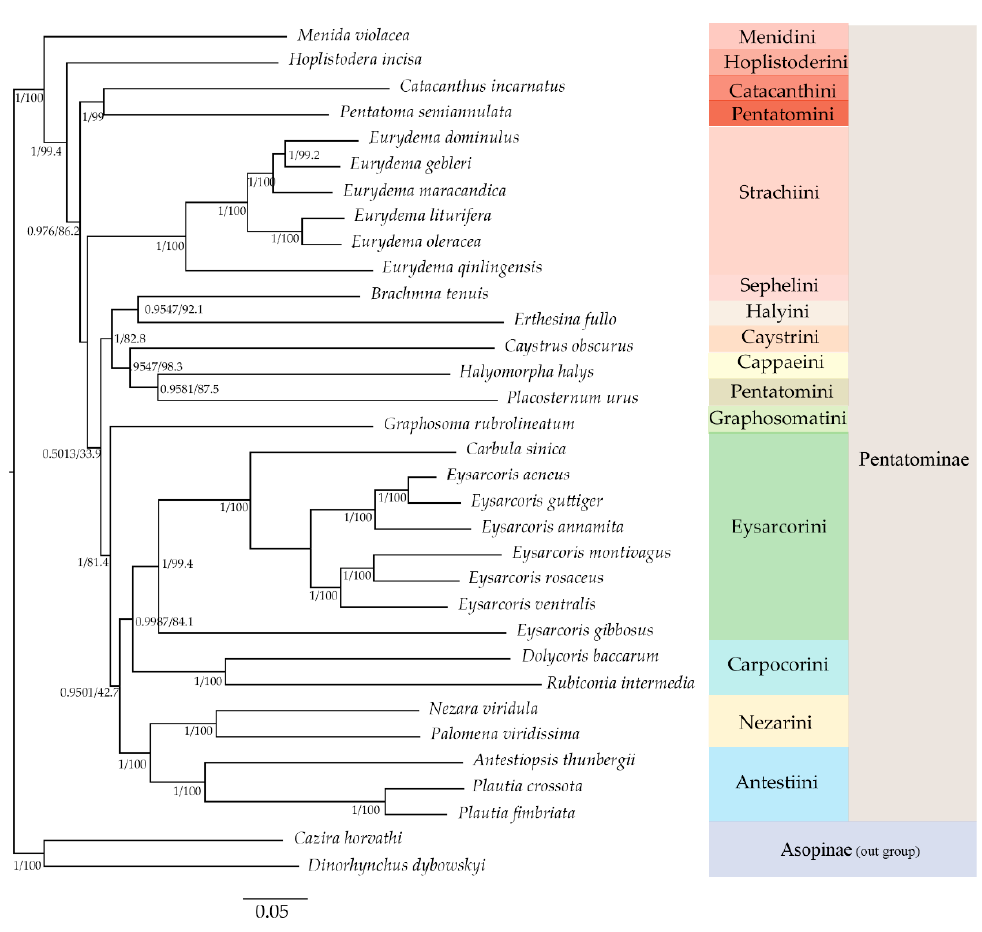
Figure 8. The phylogenetic relationships of tribes within Pentatominae reconstructed from DNA sequences of 13 protein coding and 2 rRNA mitochondrial genes using BI and ML methods.